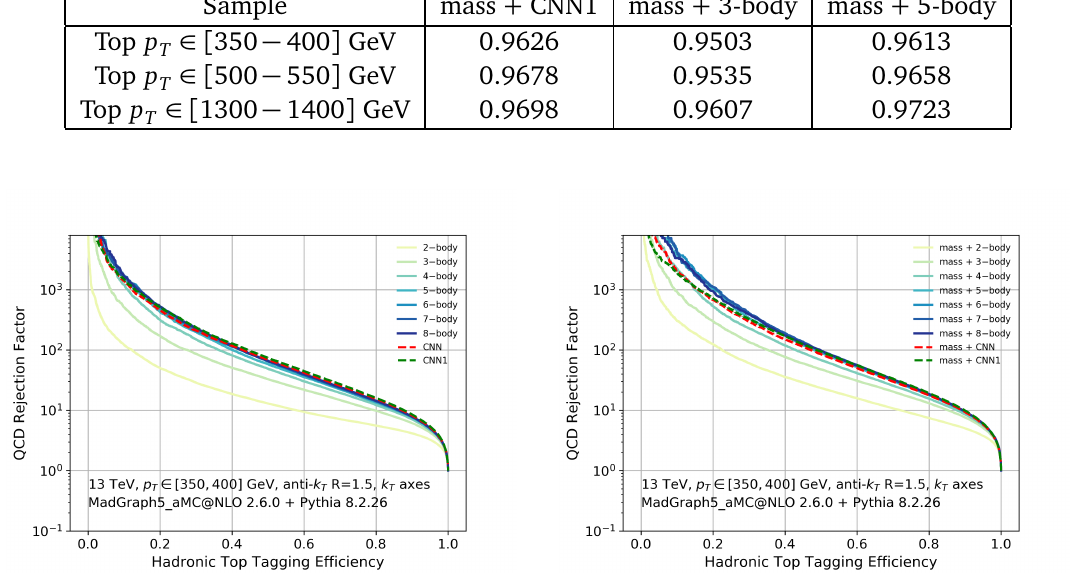
Figure 4: ROC curves for top quark tagging without mass on the left and with mass ∈ [ 350,400 ] GeV. Adding mass information improves the perfor- on the right, for p T mance of the image networks and the n -subjettiness